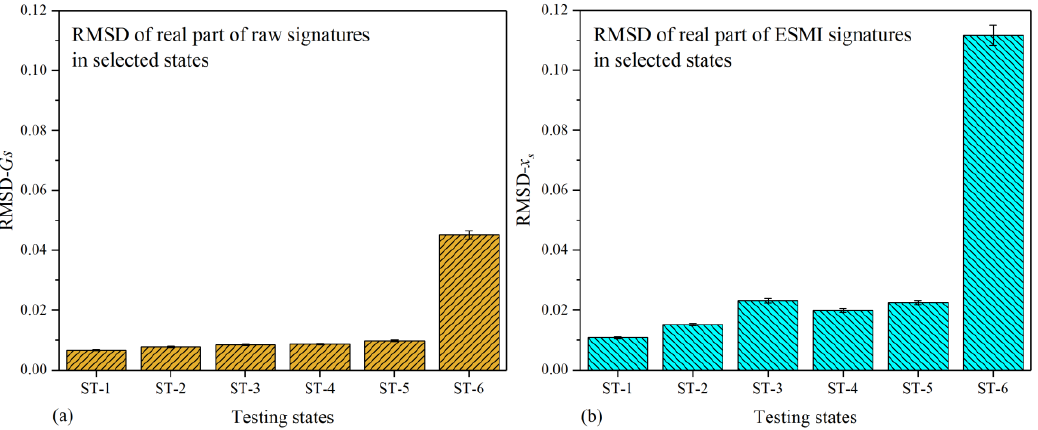
Figure 6. Histogram of real part of raw and ESMI signatures: ( a ) G s ; ( b ) x s .